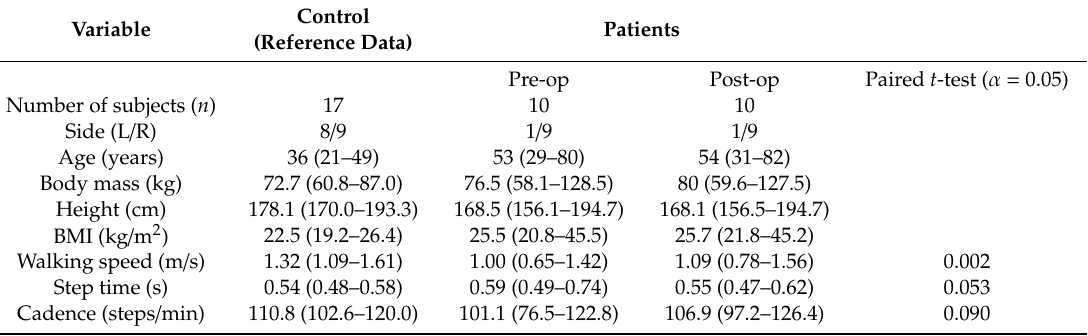
Table 1. Demographic and spatiotemporal data (median